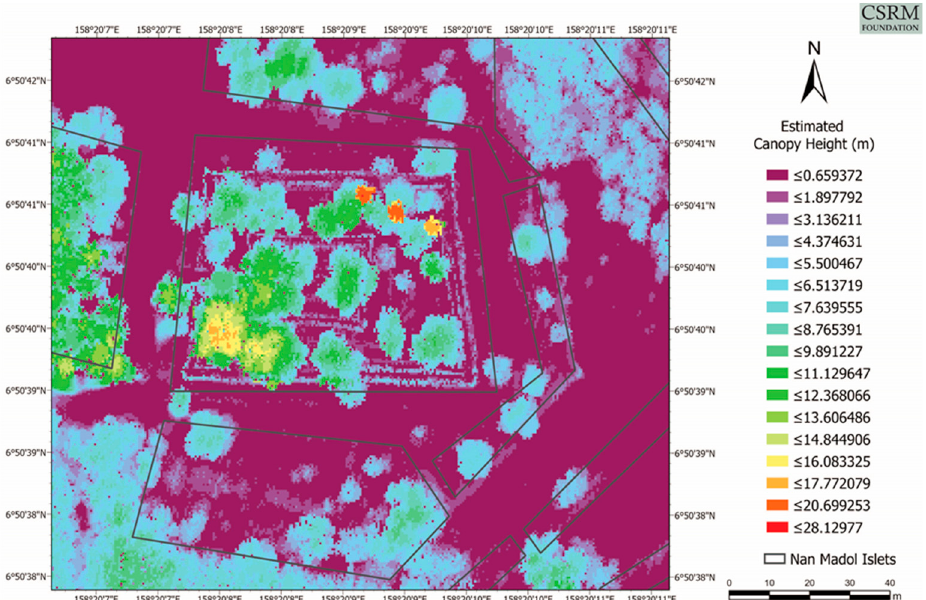
Figure 9. Estimated canopy height and density at Nan Dowas. Note that the model shows three trees with heights between 17.8 and 28.1 m. As height is an important selection criterion for vegetation removal, models like this one will be important tools for vegetation management.